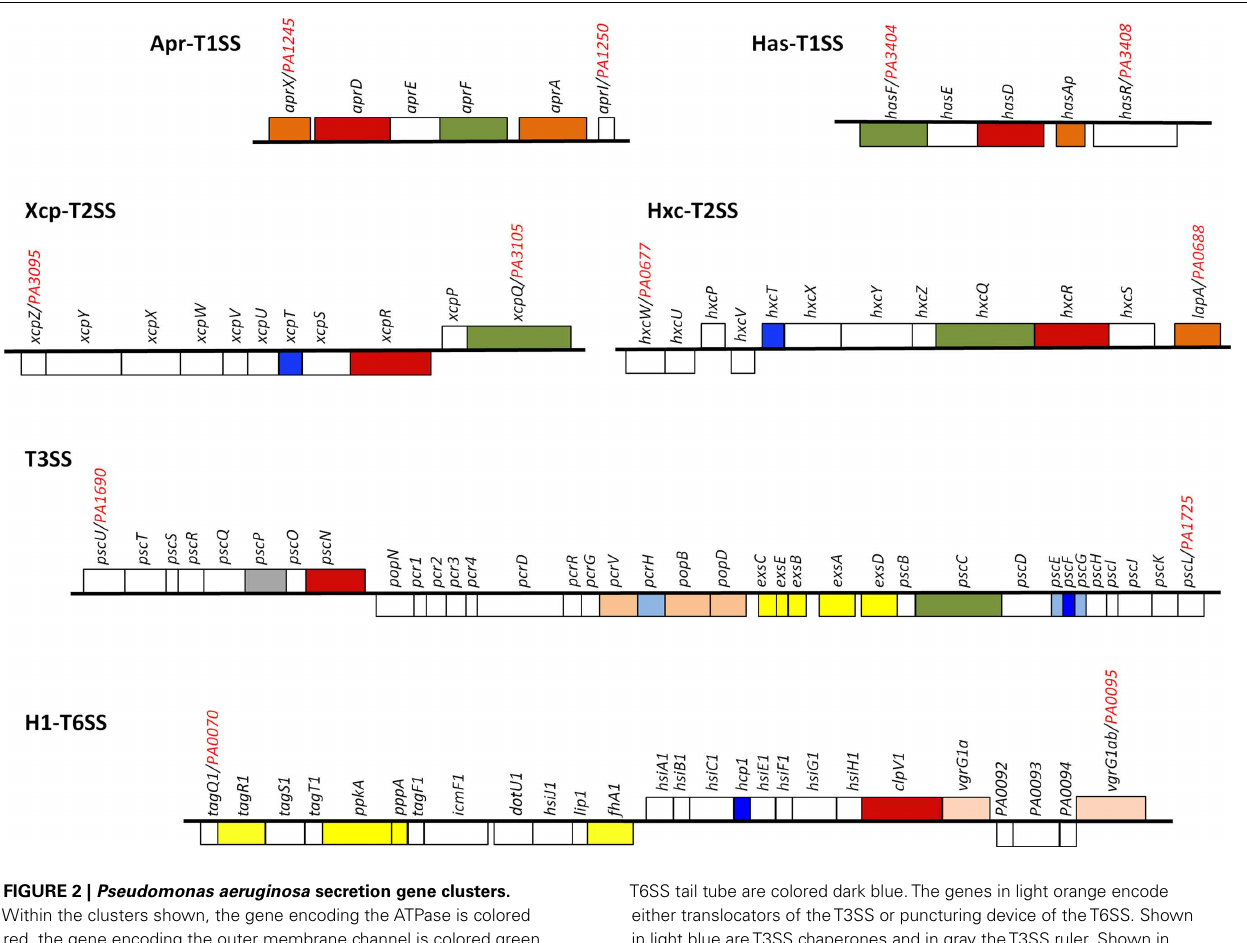
FIGURE 2 | Pseudomonas aeruginosa secretion gene clusters. Within the clusters shown, the gene encoding the ATPase is colored red, the gene encoding the outer membrane channel is colored green. The genes encoding secreted proteins are colored dark orange. Genes encoding components of theT2SS pseudopilus, theT3SS needle and the